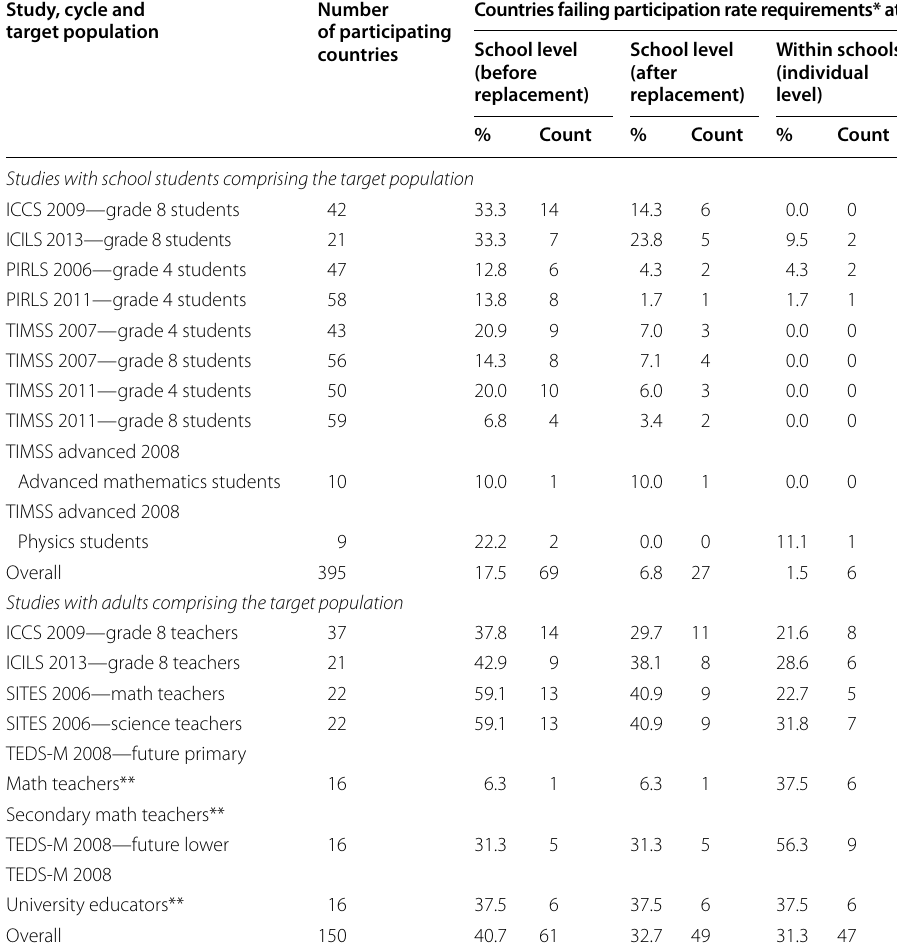
Table 1 Percentages of countries failing the participation rate requirements in IEA studies (last 10